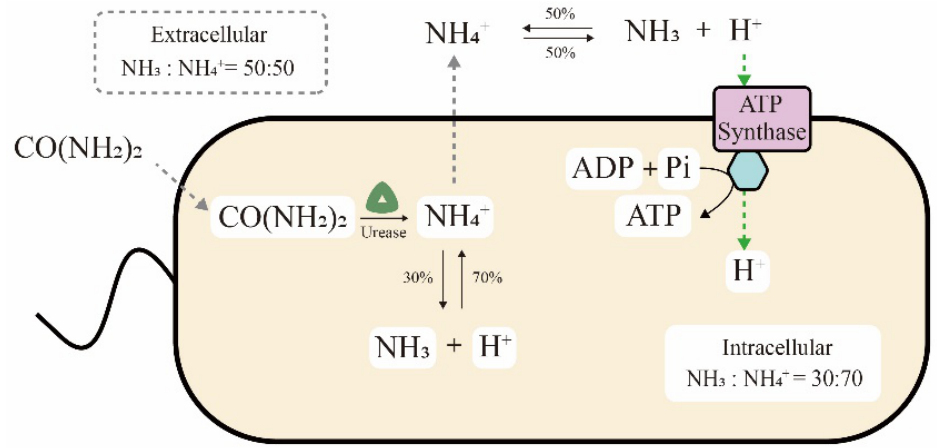
Figure 3. ATP generation through the proton electrochemical potential induced by urea hydrolysis.